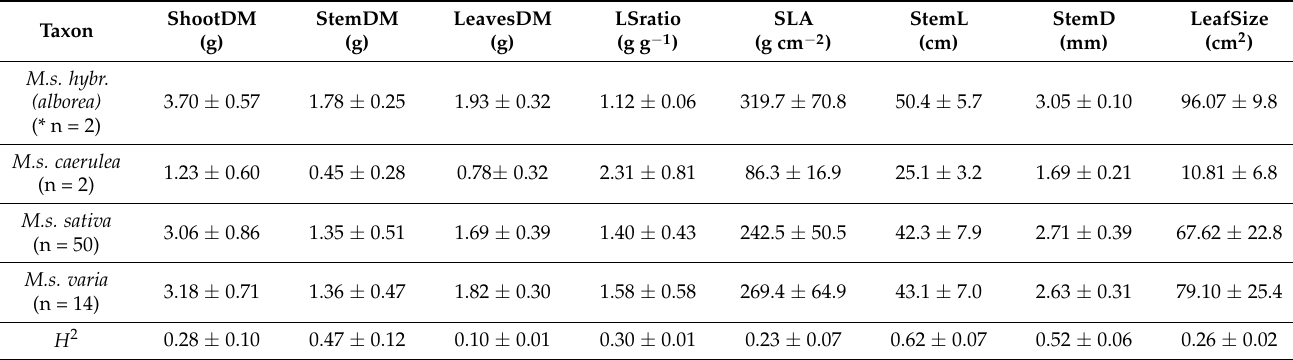
Table 2. Mean ± standard deviation and broad sense heritability ( H 2 ± SE) of eight morphological traits evaluated in an alfalfa diversity panel including accessions belonging to four subspecies M. sativa subsp. sativa , M. sativa subsp. caerulea , M. sativa subsp. varia and M. sativa subsp. alborea . Phenotypic characterization was performed during the second growing season (2019–2020) in Mediterranean drought-prone environment of